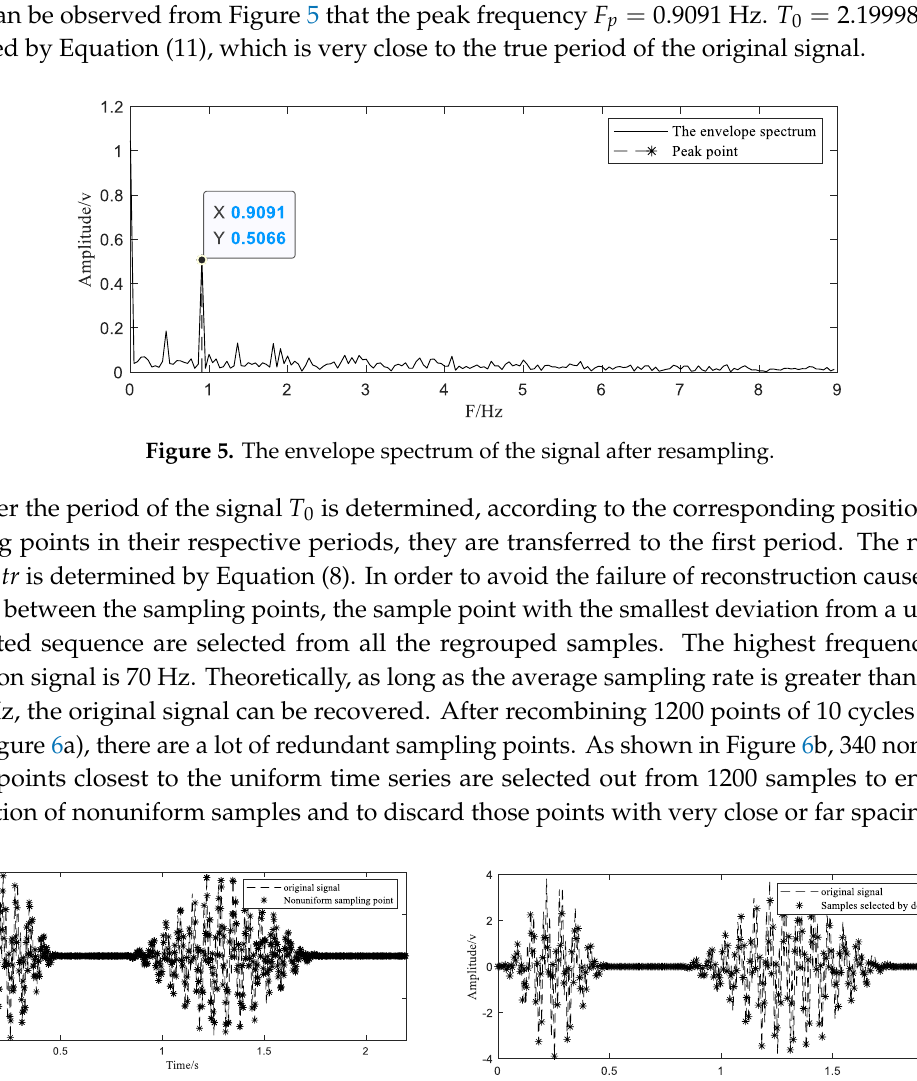
Figure 7. Comparison between reconstructed signal and original signal.